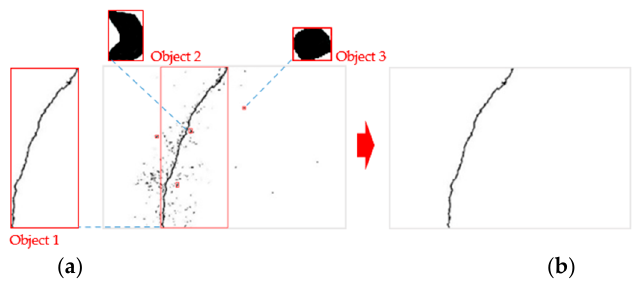
Figure 11. Illustration of noise removal. ( a ) Object’s rectangle frame ( b ) Result.